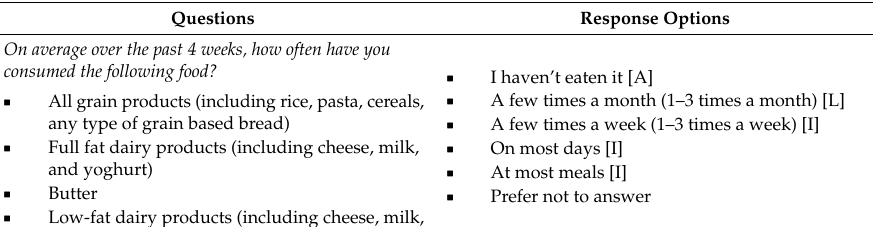
Table 1. Food profiling questions and response options from the Sovereign Wellbeing Index,